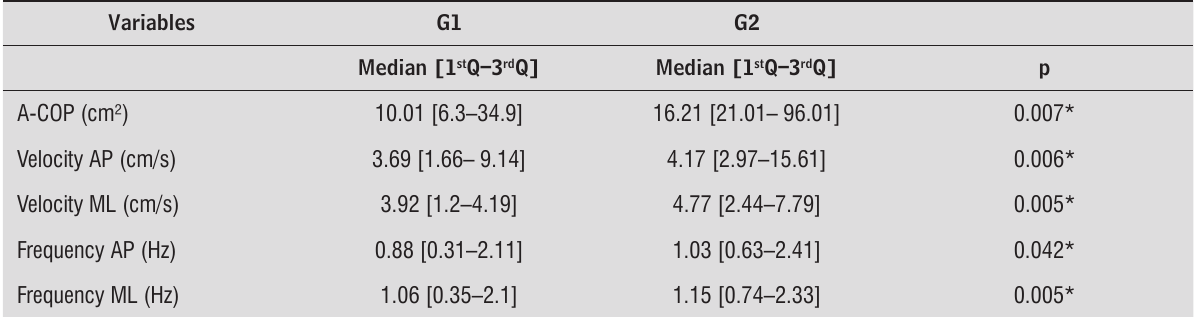
Table 2 - Comparison between groups of postural balance measures through force